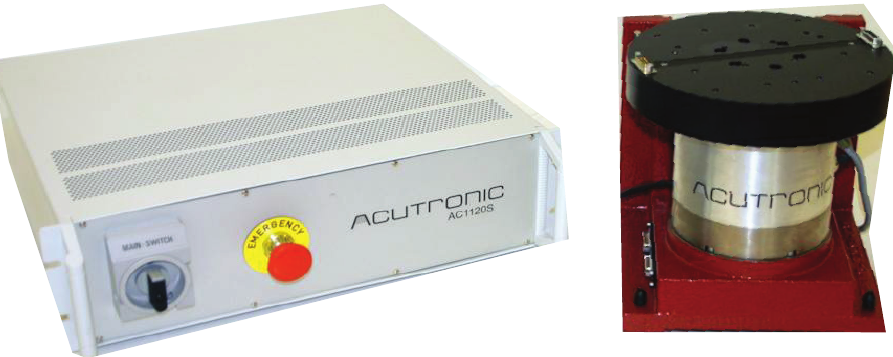
Figure 3. Instrumented turntable used in the complex calibration. The Acutronic AC11205 has a precision of 0.0001% over 360 degrees. A custom aluminum block is mounted on top of the turntable with screws to ensure proper sensor placement and